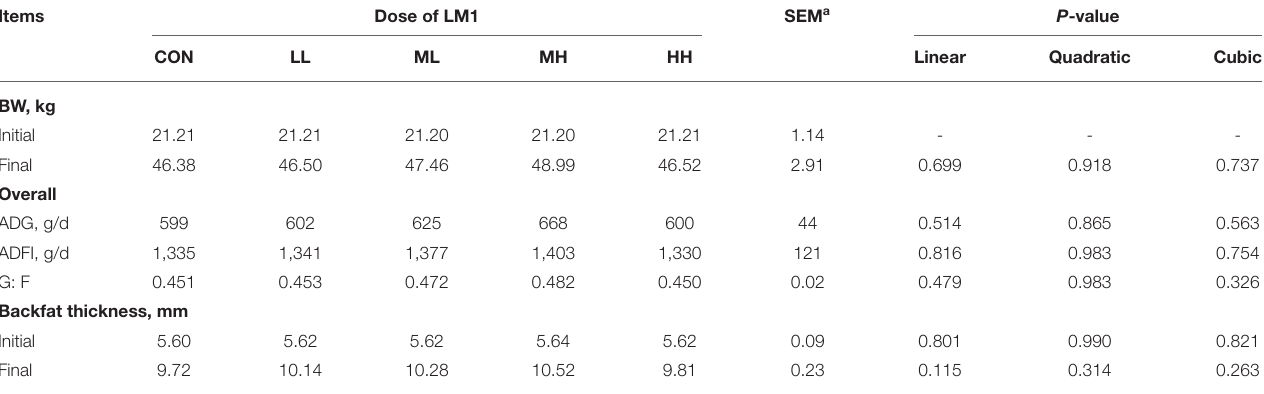
TABLE 2 | Effects of dietary LM1 on growth performance and backfat thickness of growing pigs.